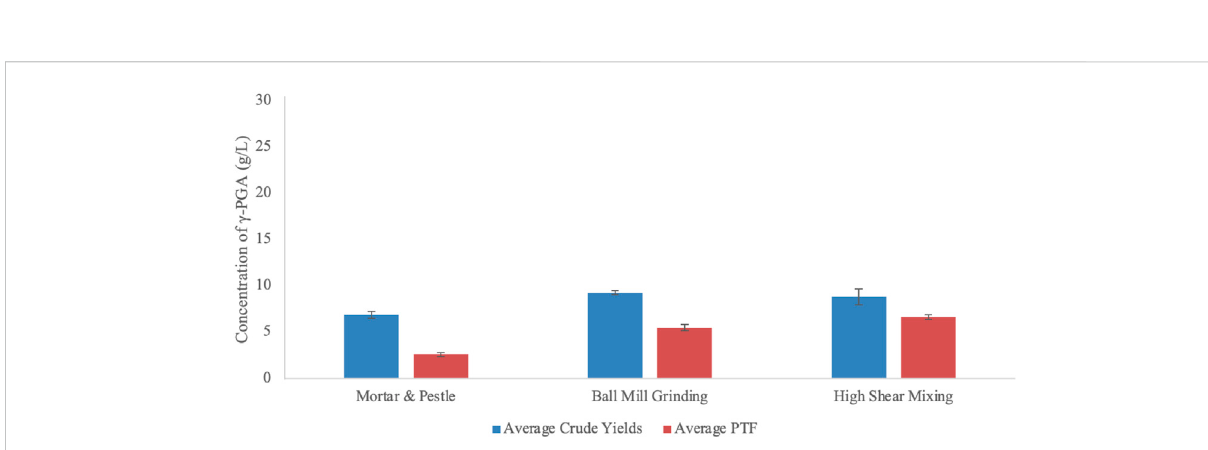
FIGURE 10 Averageyieldsof γ -PGA(rawandPTF)obtainedfrom Laminariadigitata commercial fl akesundergonedifferentpre-treatmenttechniques.Errorbars indicate standard deviation (n = 3 shake fl ask).